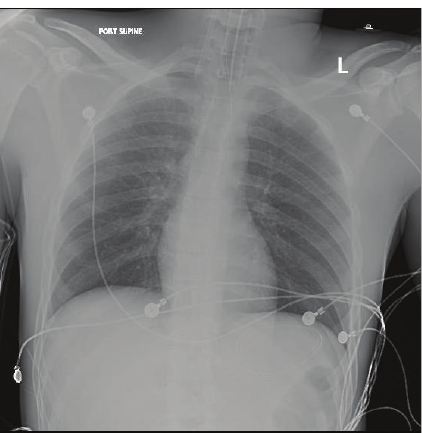
Figure 1: Chest X-ray post-op.